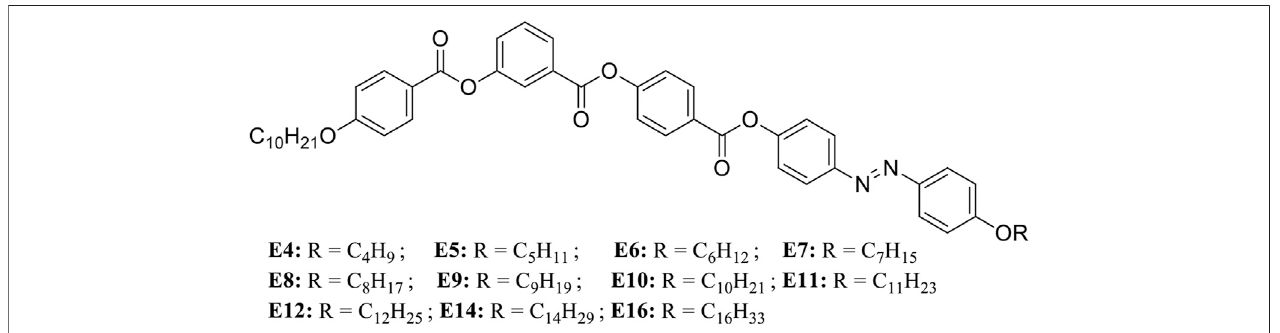
FIGURE 1 | Molecular structure of the HSLCs (E) compounds [18].